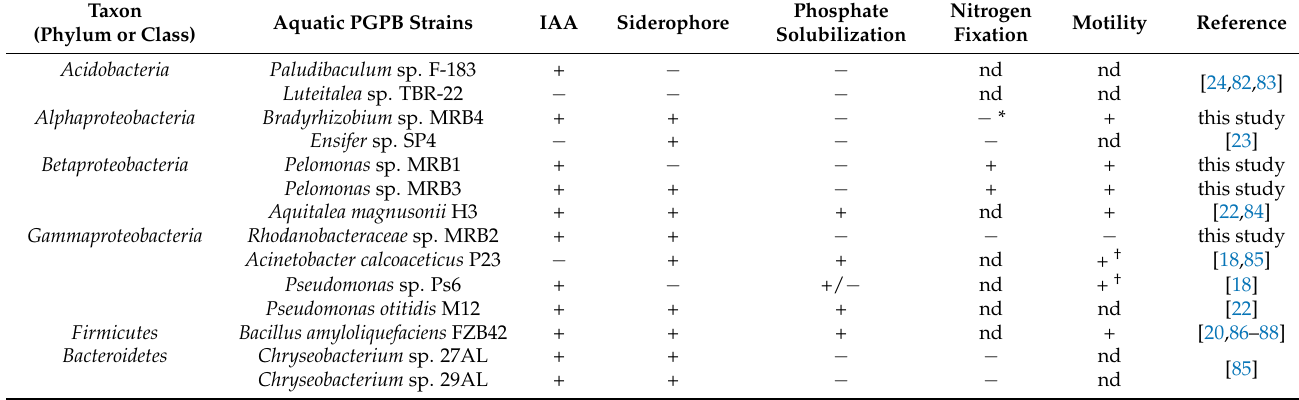
Table 2. Plant growth-promoting factors and motility of the obtained strains MRB1–4 and known PGPB for duckweeds. IAA: indole-3-acetic acid. The symbols indicate the following: +, positive; +/ − , slightly positive; − , negative; nd, no